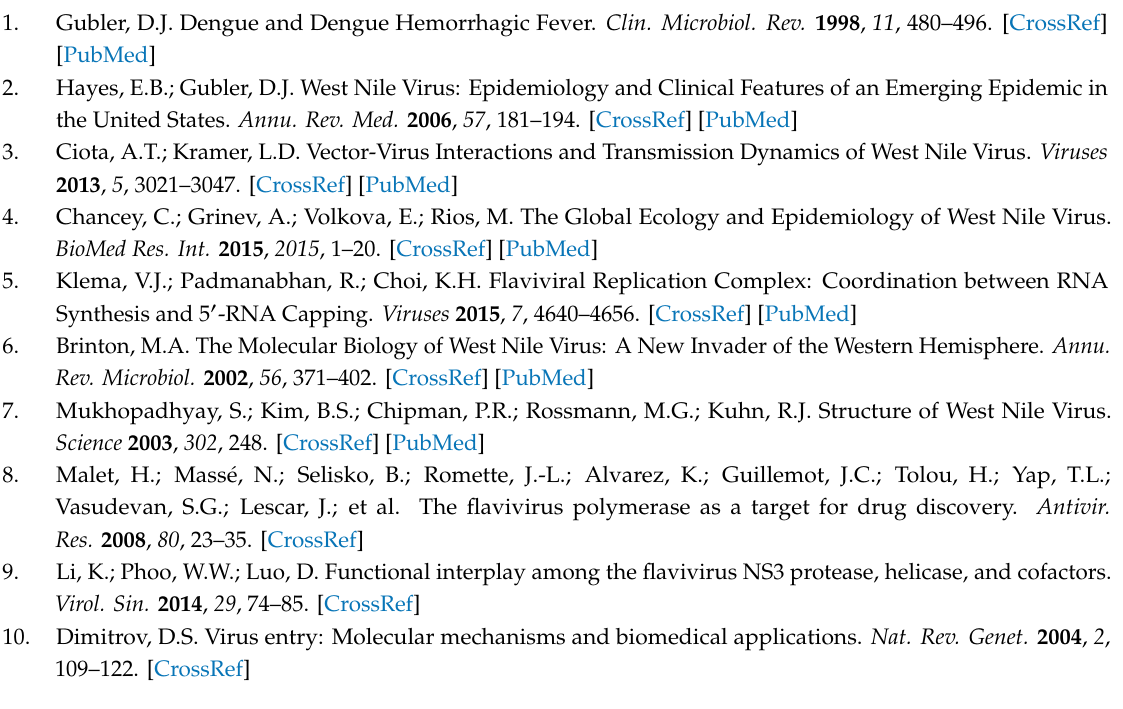
Table S1: New York State Surveillance Isolates